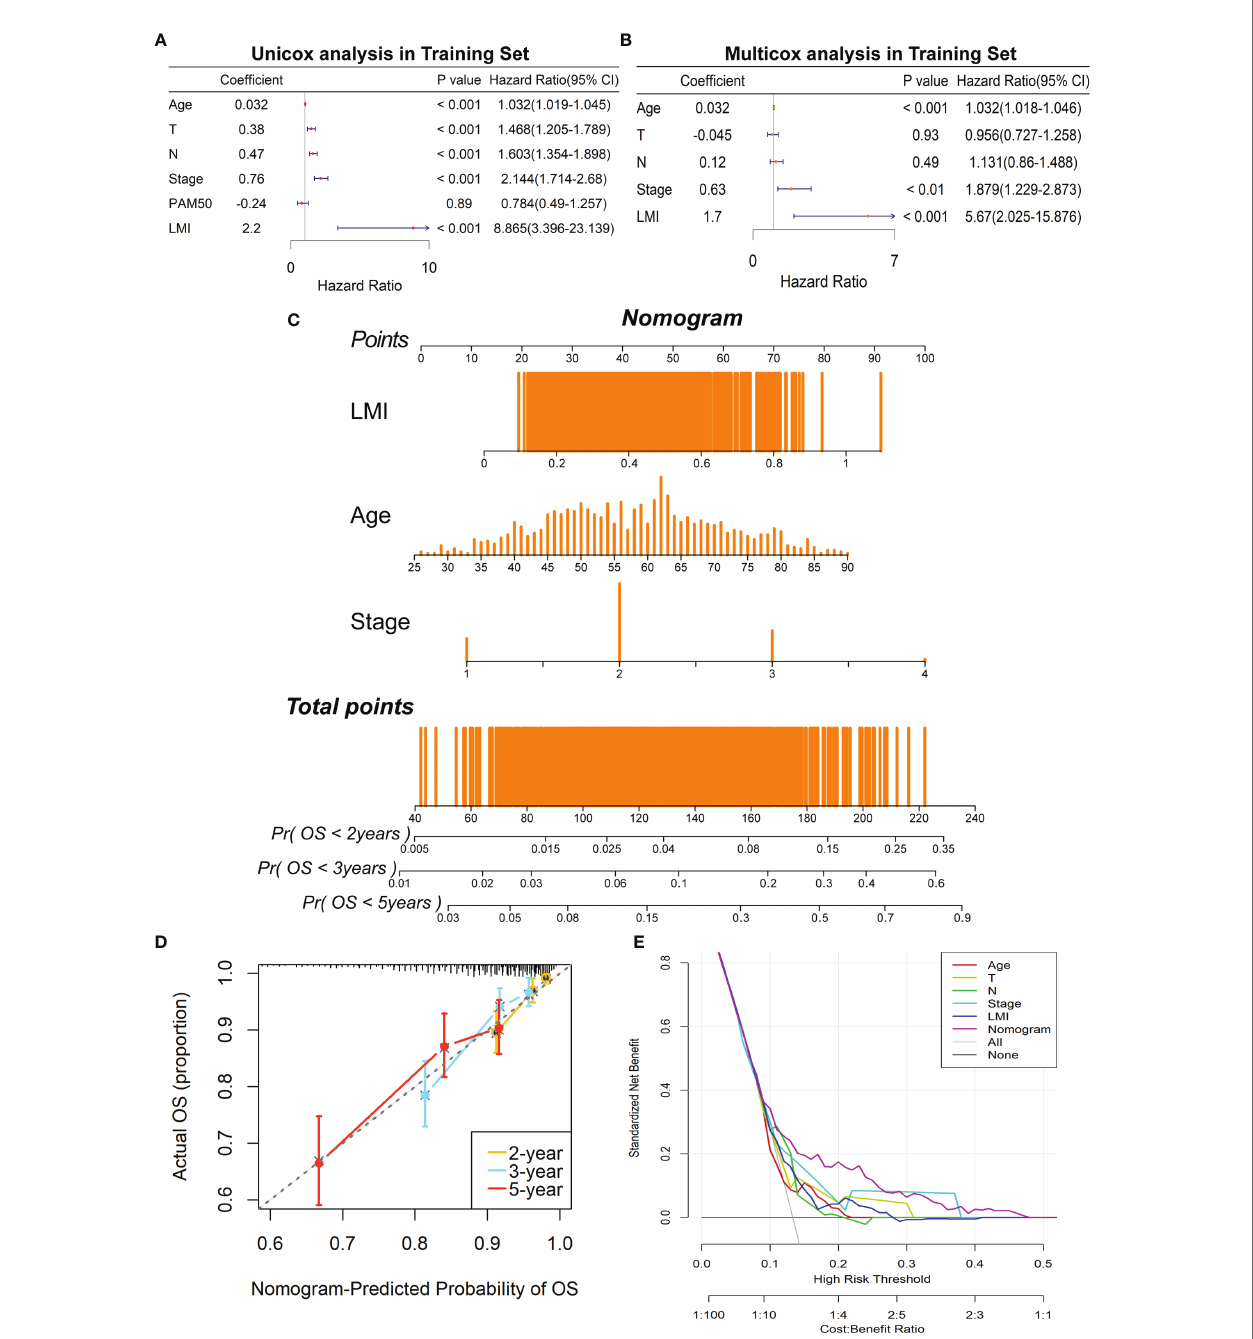
FIGURE 5 | Construction of a prognostic nomogram containing LMI signature in the training set. (A) Univariate Cox regression analysis of age, T stage, N stage, AJCC stage, PAM50 subtypes, and LMI for OS. (B) Multivariate Cox regression analysis of age, T stage, N stage, AJCC stage, and LMI for OS. (C) Nomogram for the prediction of 2-, 3-, and 5-year survival probability. (D) The calibration plot to assess the consistency of predicted and actual OS based on the nomogram. (E) Decision curve analysis (DCA) for evaluating clinical utility of the